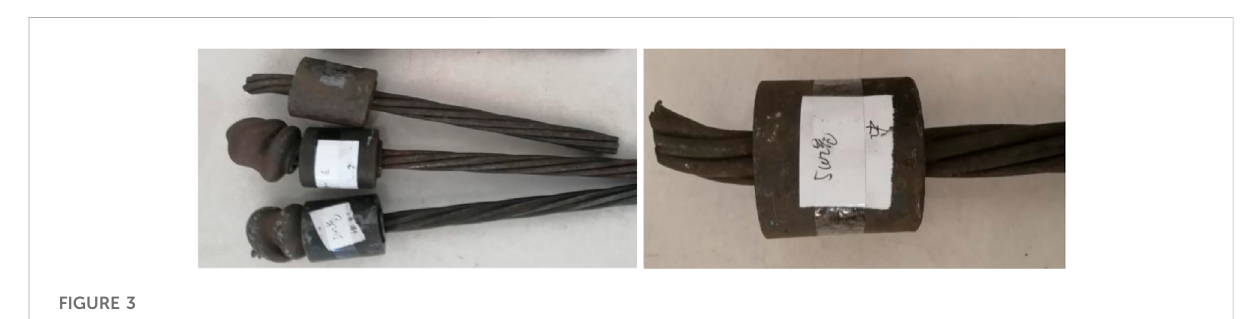
FIGURE 3 Breaking form of